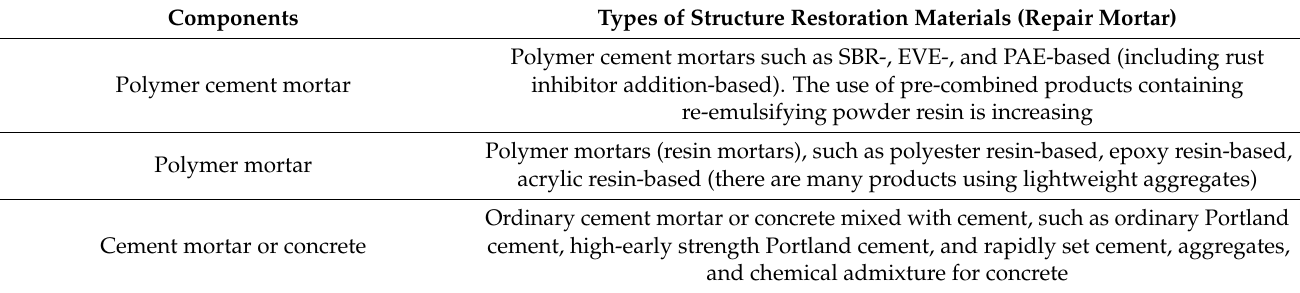
Table 2. Types of structure protection materials.